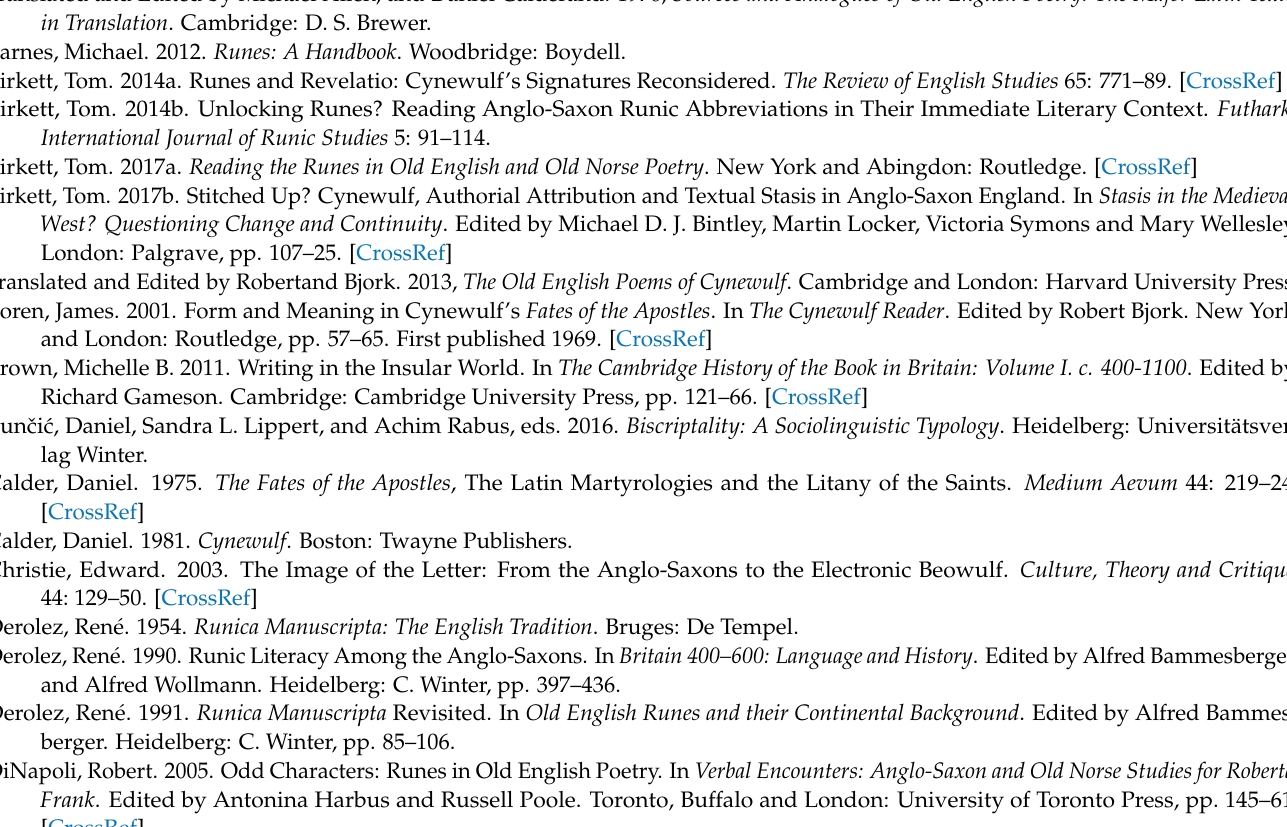
Figure 1. Detail from the signature passage in The Fates of the Apostles . “ ᚢ ・ ” concludes its line on the right, “ on eðle ” begins the next. Biblioteca Capitolare of Vercelli, (MS. CXVII, Codex Vercellensis, f. 54 r ) Copyright: Fondazione Museo del Tesoro del Duomo e Archivio Capitolare di Vercelli. Permission for reproduction granted by Silvia Faccin—Curator of manuscripts and rare books of Biblioteca